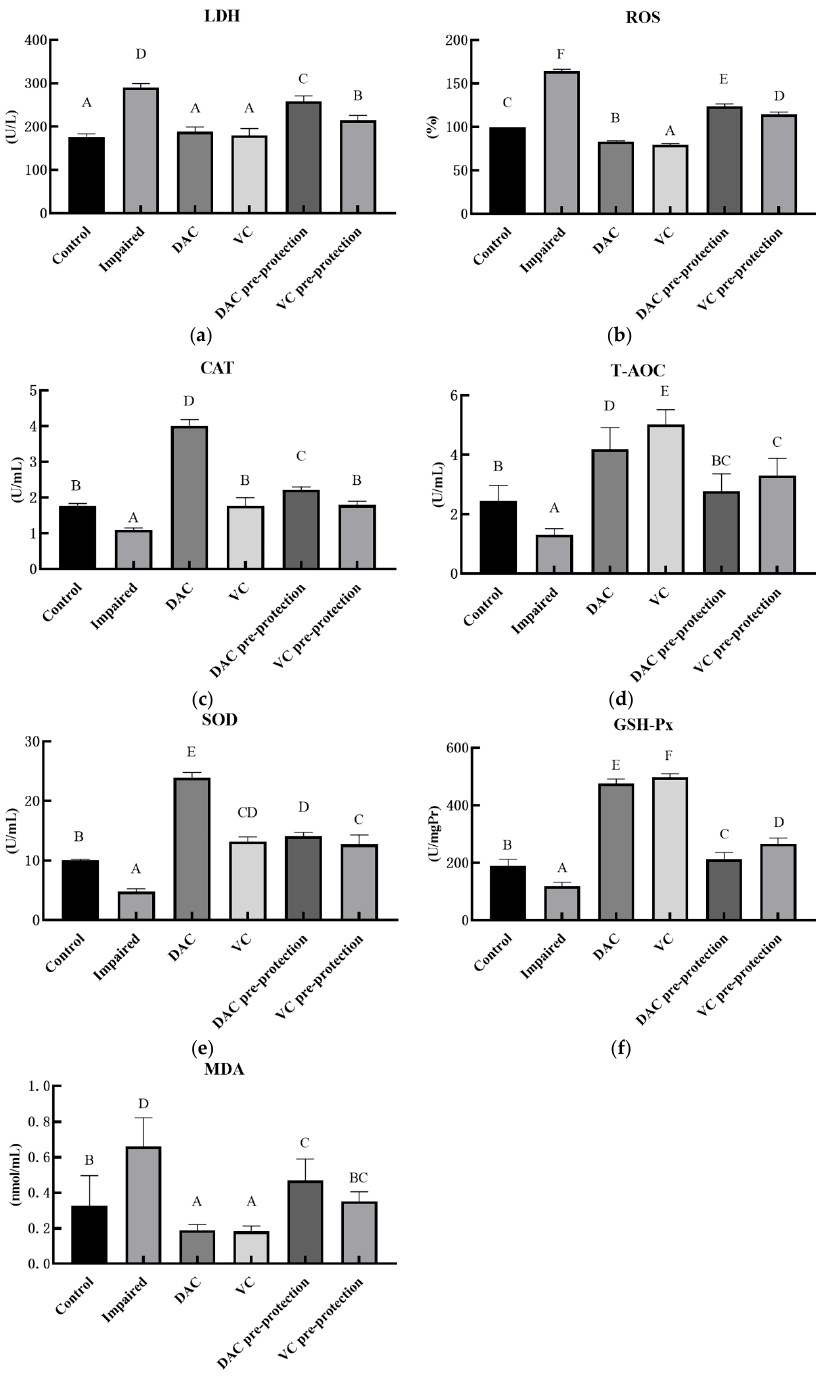
Figure 2. Effect of DAC pre-protection on antioxidant capacity of GMEC. The main indicators reflecting the antioxidant capacity of cells include: (a) LDH activity, (b) ROS relative content, (c) CAT activity, (d) T-AOC, (e) SOD activity, (f) GSH-Px activity, and (g) MDA contents. Compared with the control group, in the graph, values with different capital letter superscripts mean significant difference (p < 0.05), while with the same letter superscripts mean no significant difference (p > 0.05). The same as below of the figure.